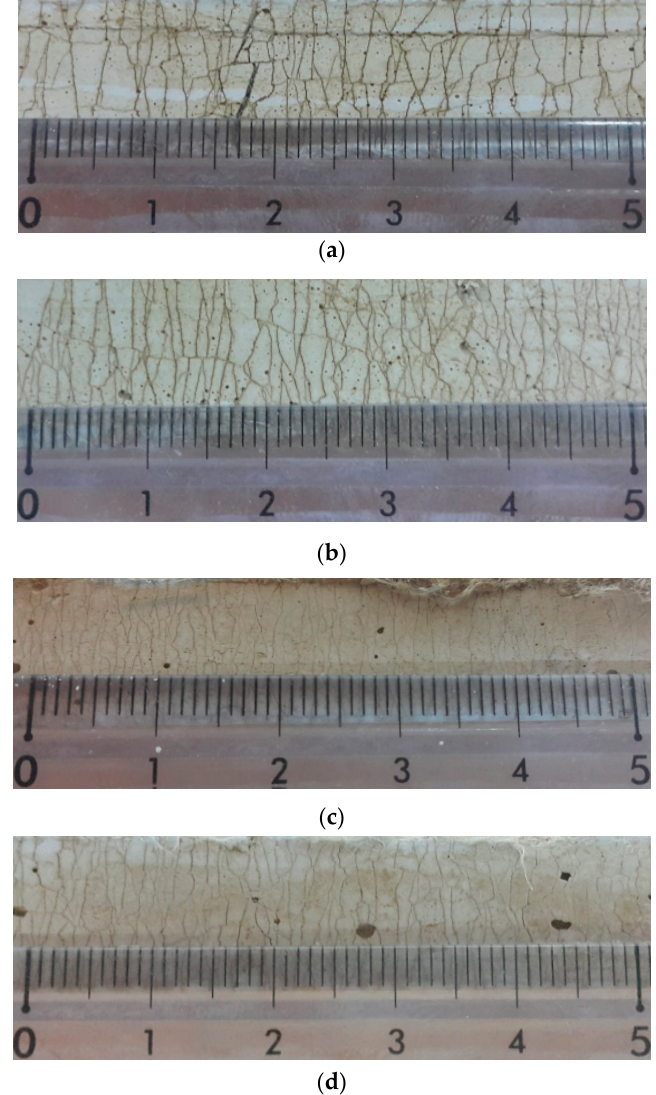
Figure 9. Representative cracking patterns: ( a ) W21-S0, ( b ) W21-S5, ( c ) W25-S5, and ( d ) W30-S5.